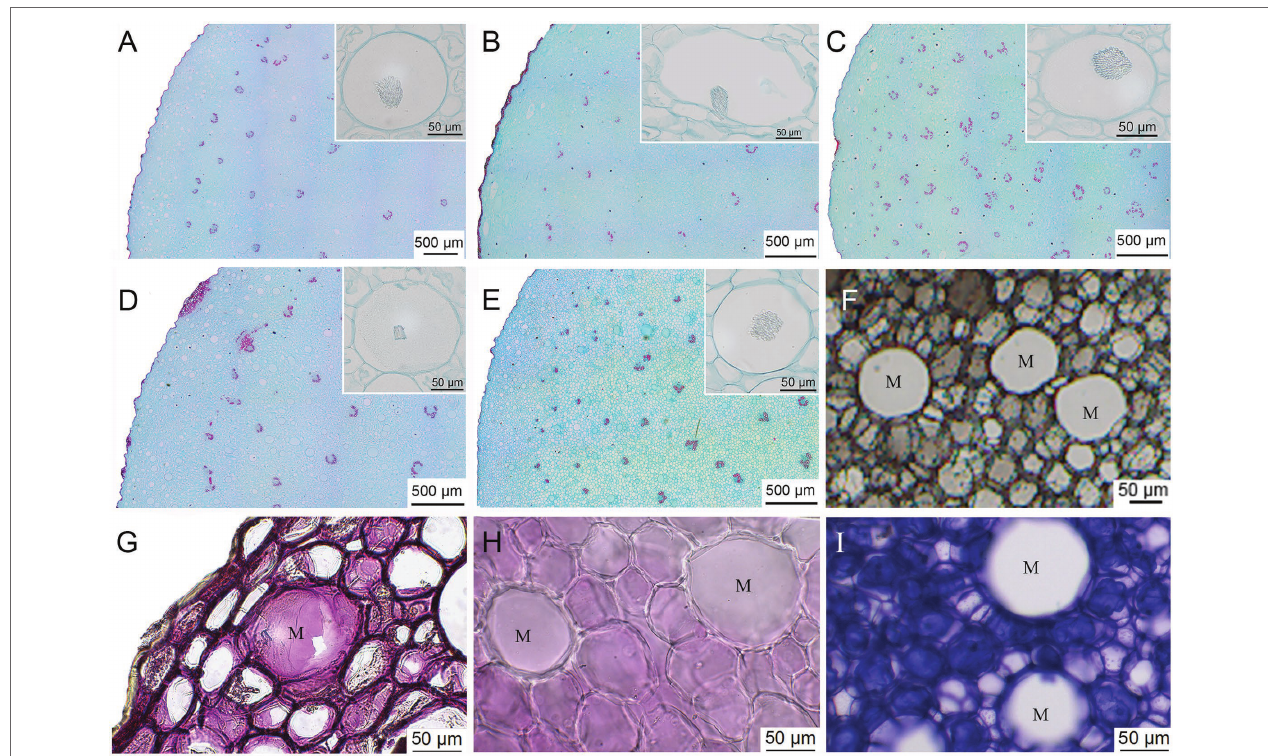
FIGURE 2 | The cross-sectional microstructures of the five types of Huangjing (A) “ BaiJi -type” Polygonati rhizoma, (B) “ Jiang -type” Polygonati rhizoma, (C) “ Cylinder -type” Polygonati rhizoma, (D) “ JiTou -type” Polygonati rhizoma, and (E) atypical “ JiTou -type” Polygonati rhizoma, ink dyeing (F) , histochemical localization (G) polysaccharides—Periodic Acid-Schiff reaction, (H) saponins—5% vanillin-glacial acetic acid-perchloric acid solution reaction, (I) proteins— Coomassie brilliant blue test reaction, and M: mucilage